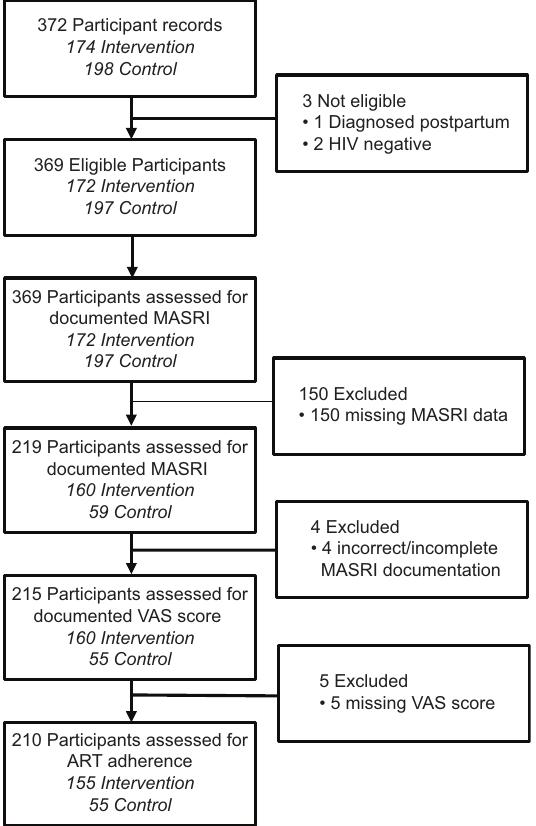
Figure 1: Flowchart depicting study activities, Niger state, northcentral